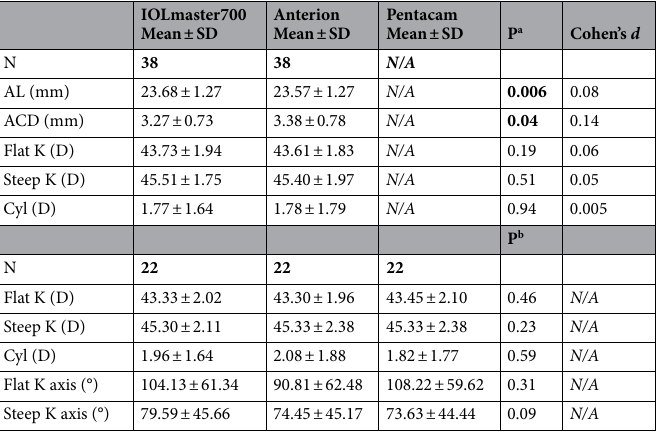
Table 3. Biometric parameters—mean differences (Group B). ACD anterior chamber depth, AL Axial length, Cyl cylinder. a Paired sample t-test. b Friedman test. Significant values are in [bold].